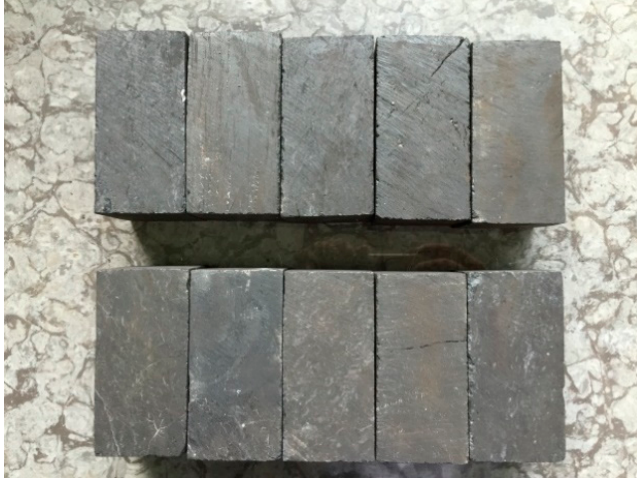
Figure 4. Coal specimen. With size of 50 (width) × 50 (height) × 100 (length) mm.